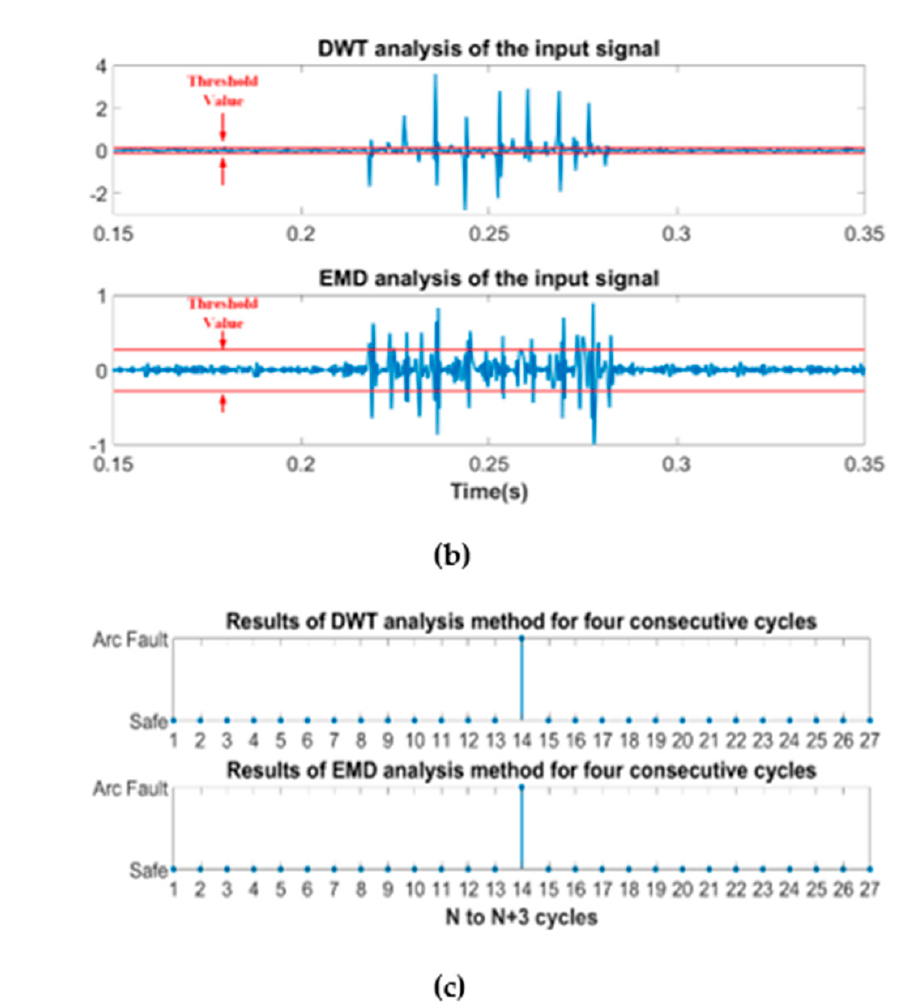
Figure 13. Series arc fault detection results of the electric oven ( a ) input current signal, ( b ) DWT and EMD analysis signals, and ( c ) the detection result of each method.